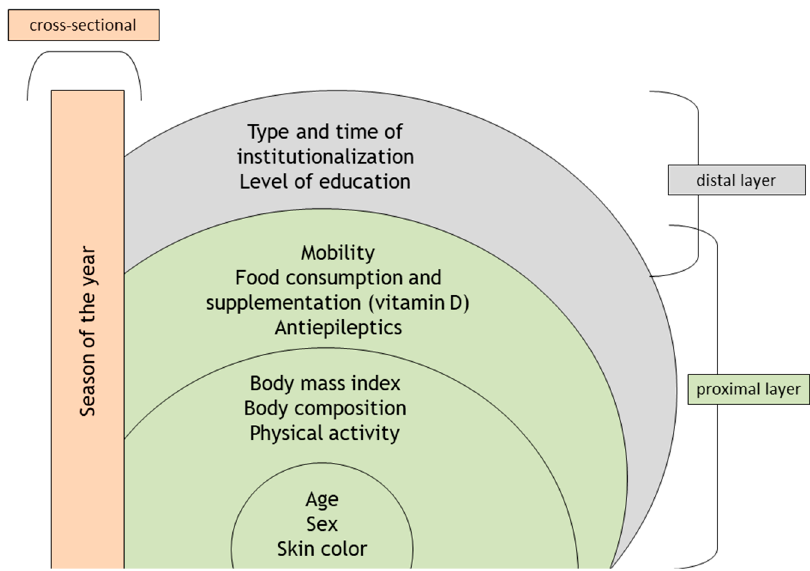
Figure 2. Theoretical model of the determinants of vitamin D status in institutionalized elderly